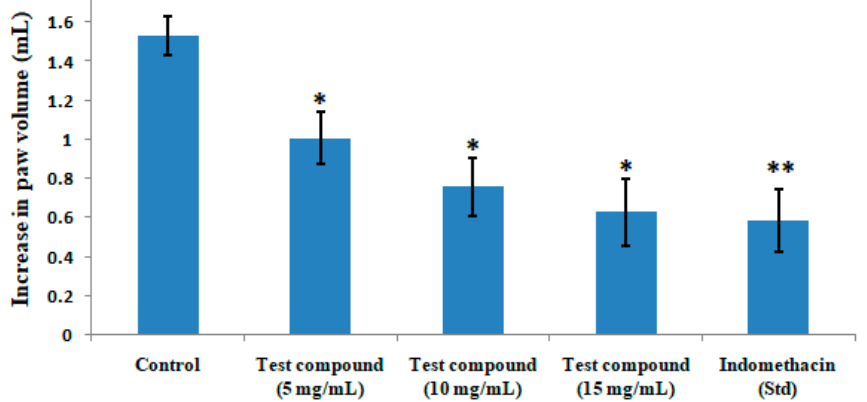
Figure 2. Effects of quercetin-3-methoxy-4 ′ -glucosyl-7-glucoside on carrageenan-induced paw edema in rats. The results represent mean ± SEM (n = 6). * p < 0.05 and ** p < 0.01 compared to the control group.